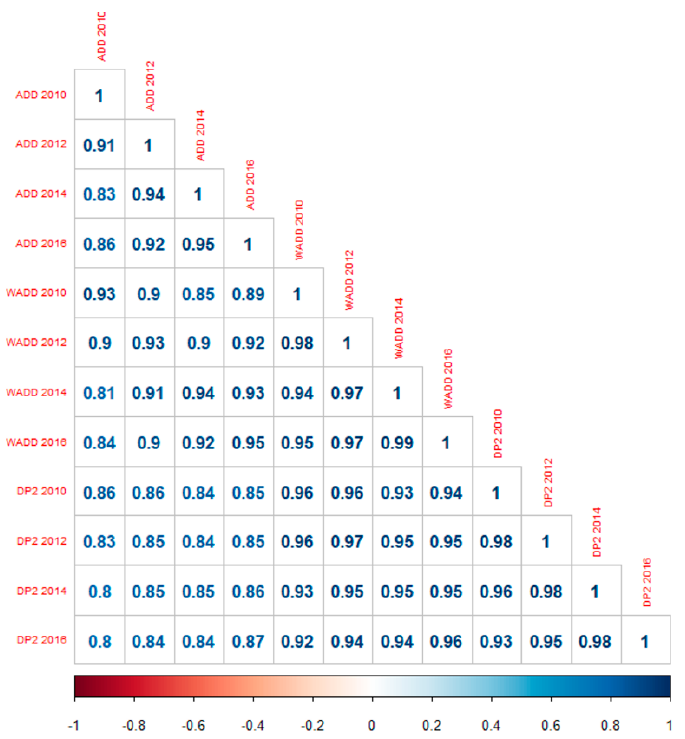
Figure 1. Spearman correlation matrix representation (years 2010, 2012, 2014, 2016).